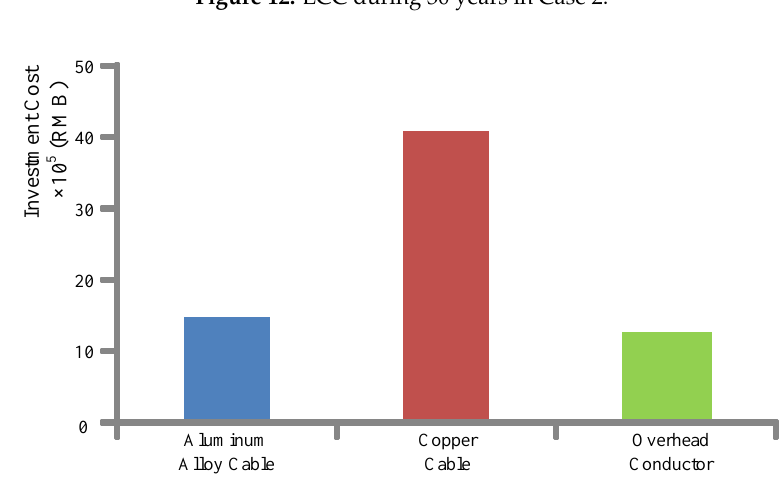
Figure 12. LCC during 30 years in Case 2.